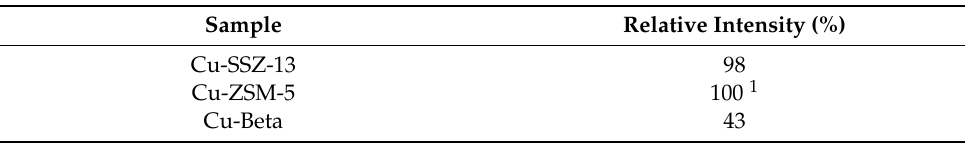
Table 2. EPR signal relative intensity for the Cu based zeolites.